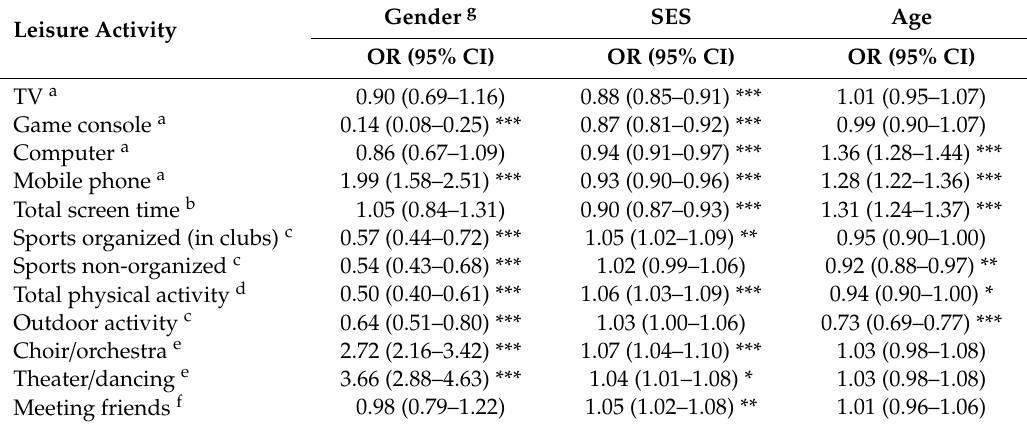
Table 2. Associations between leisure activities and gender, SES and age ( N =